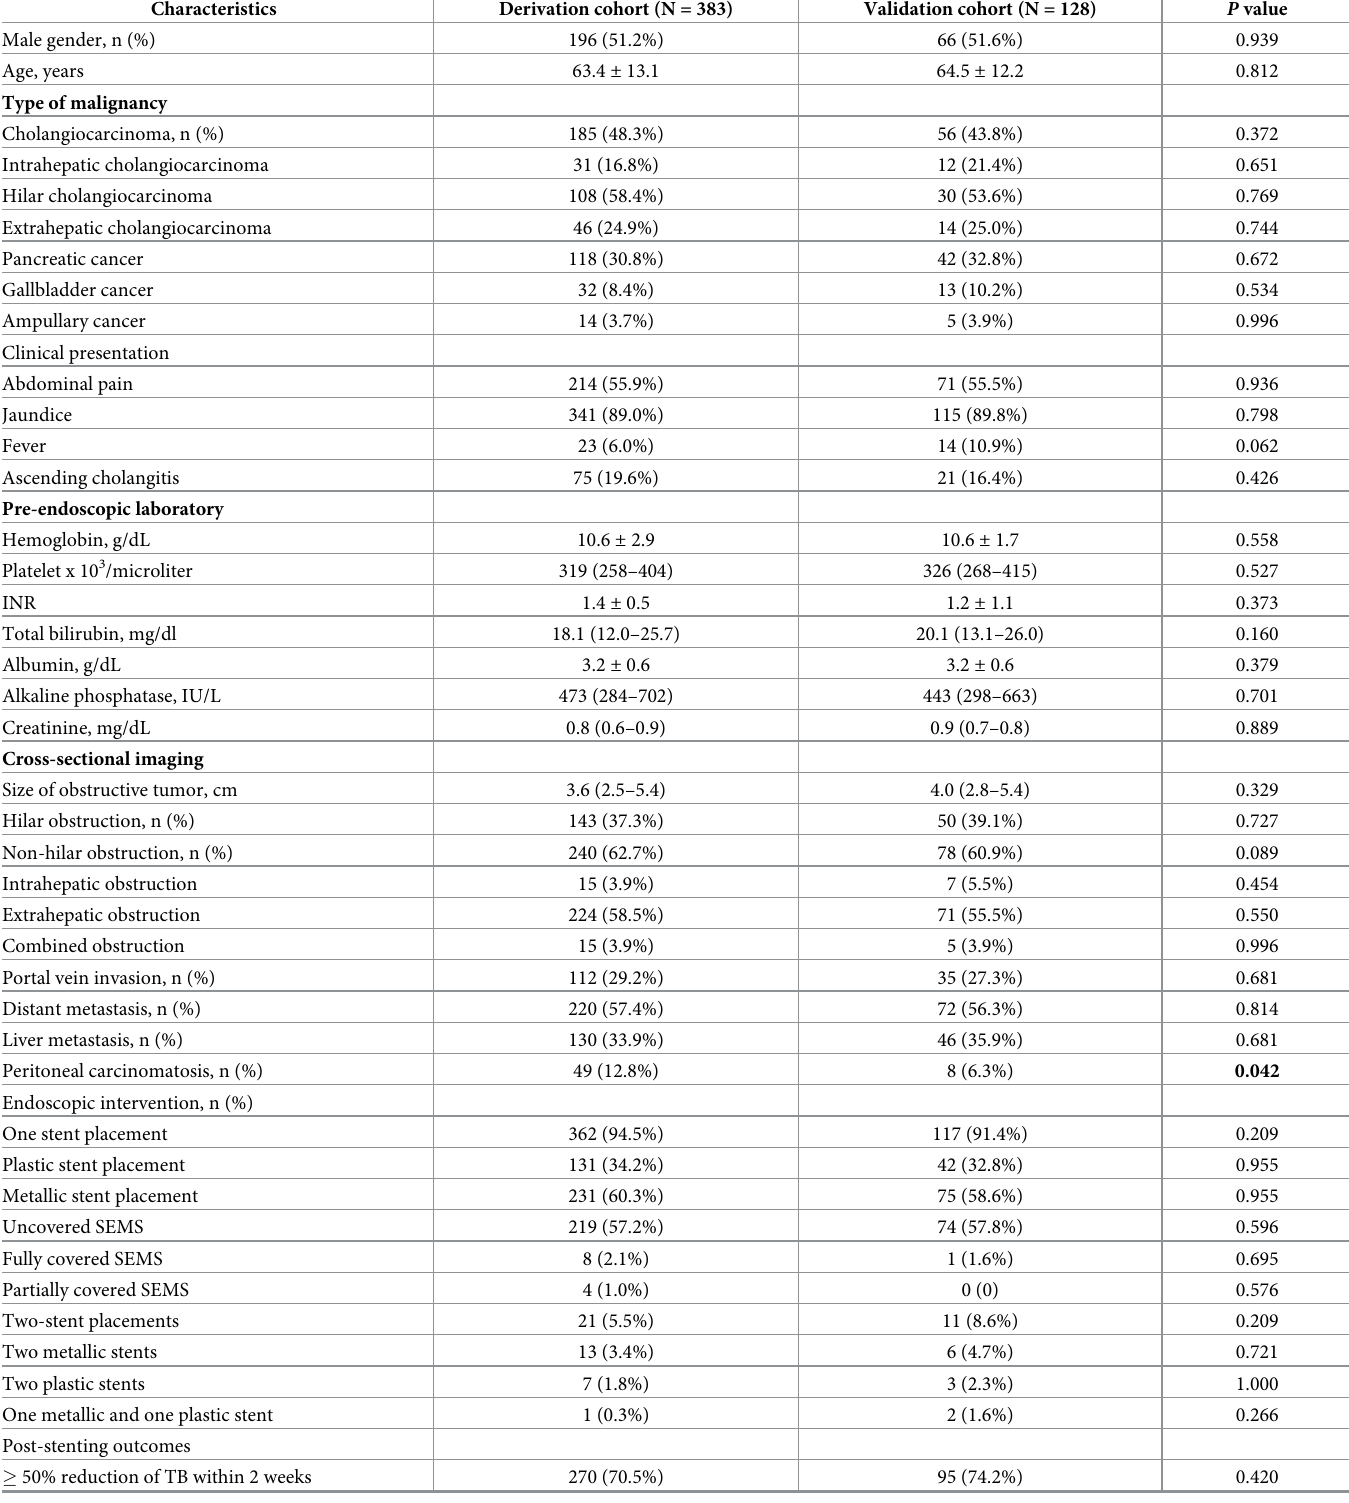
Table 1. Comparison of baseline characteristics between patients in the derivation and validation